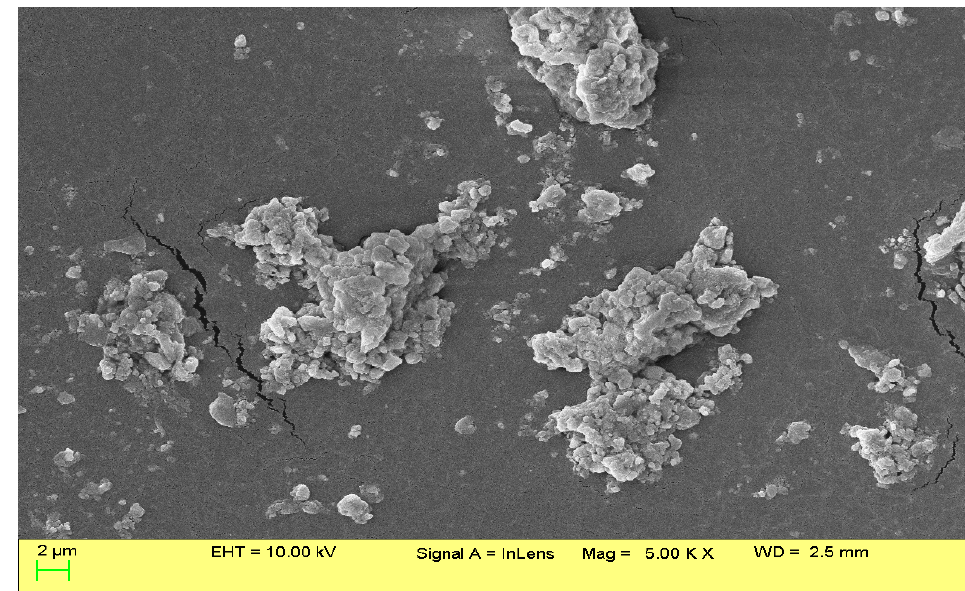
Figure 1. The SEM image of CITEO ‐ loaded